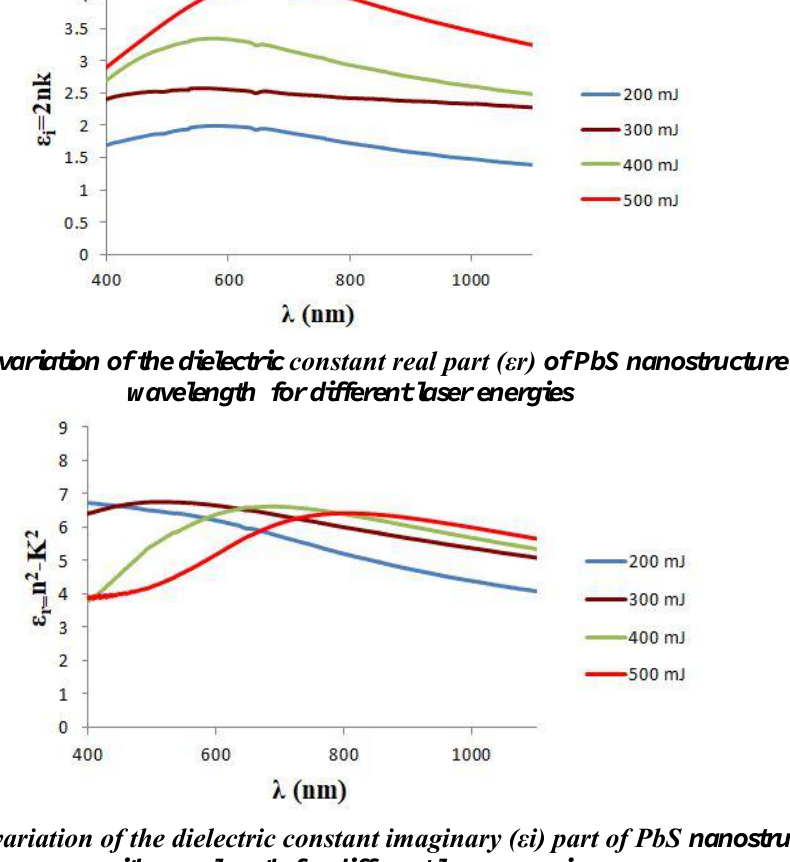
Fig.11: The variation of the dielectric constant imaginary (εi) part of PbS nanostructure with wavelength for different laser